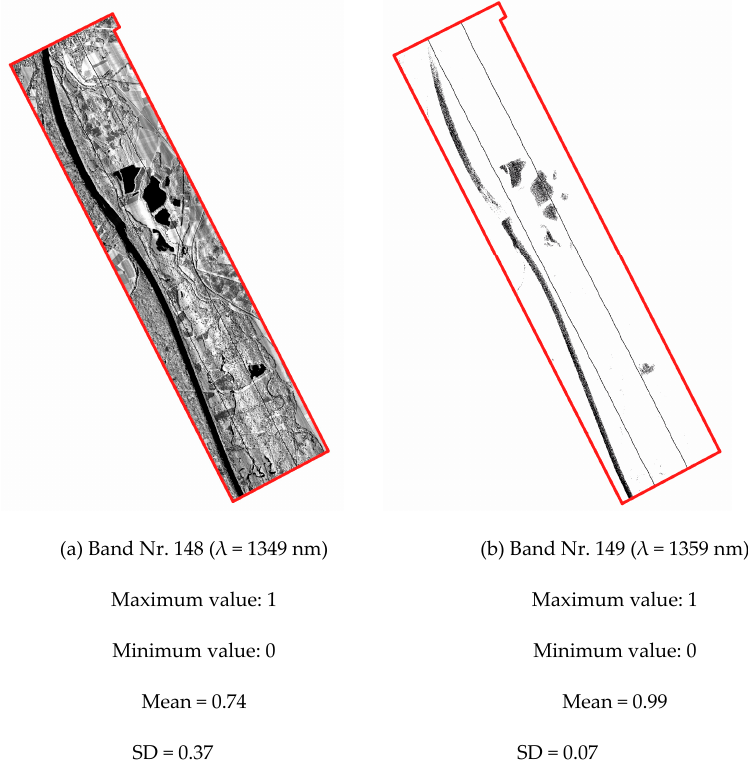
Figure 6. An illustration of a normal band (left) and a noisy band (right). The noisy bands were selected according to mean and standard deviation, as well as visual inspection.